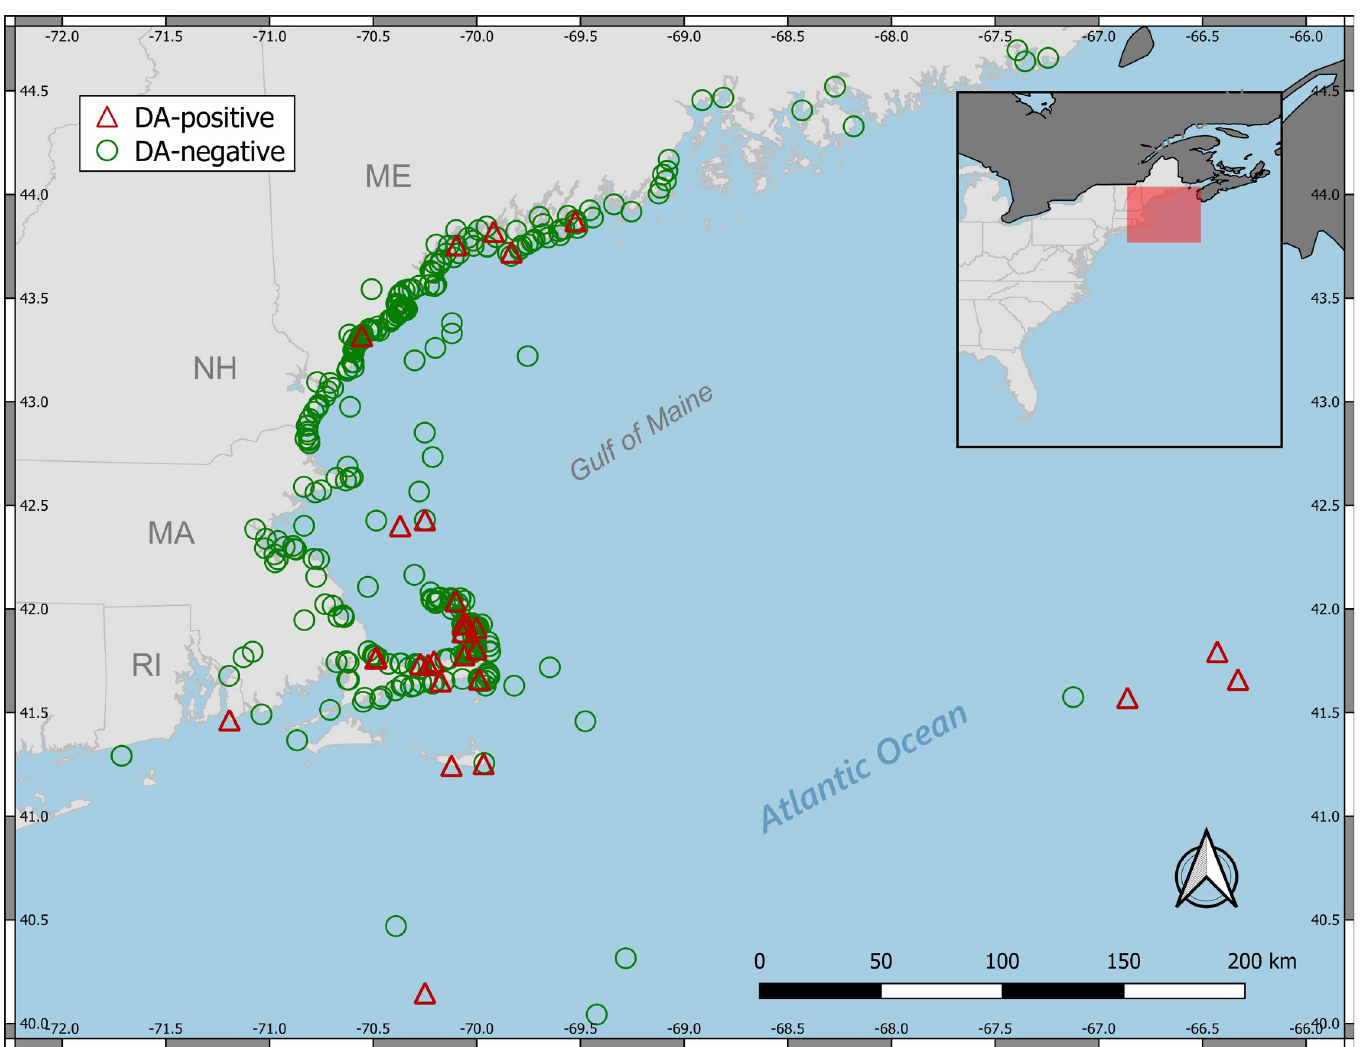
Fig 2. Animal collection/sampling locations and detections of domoic acid (presence/absence in at least one